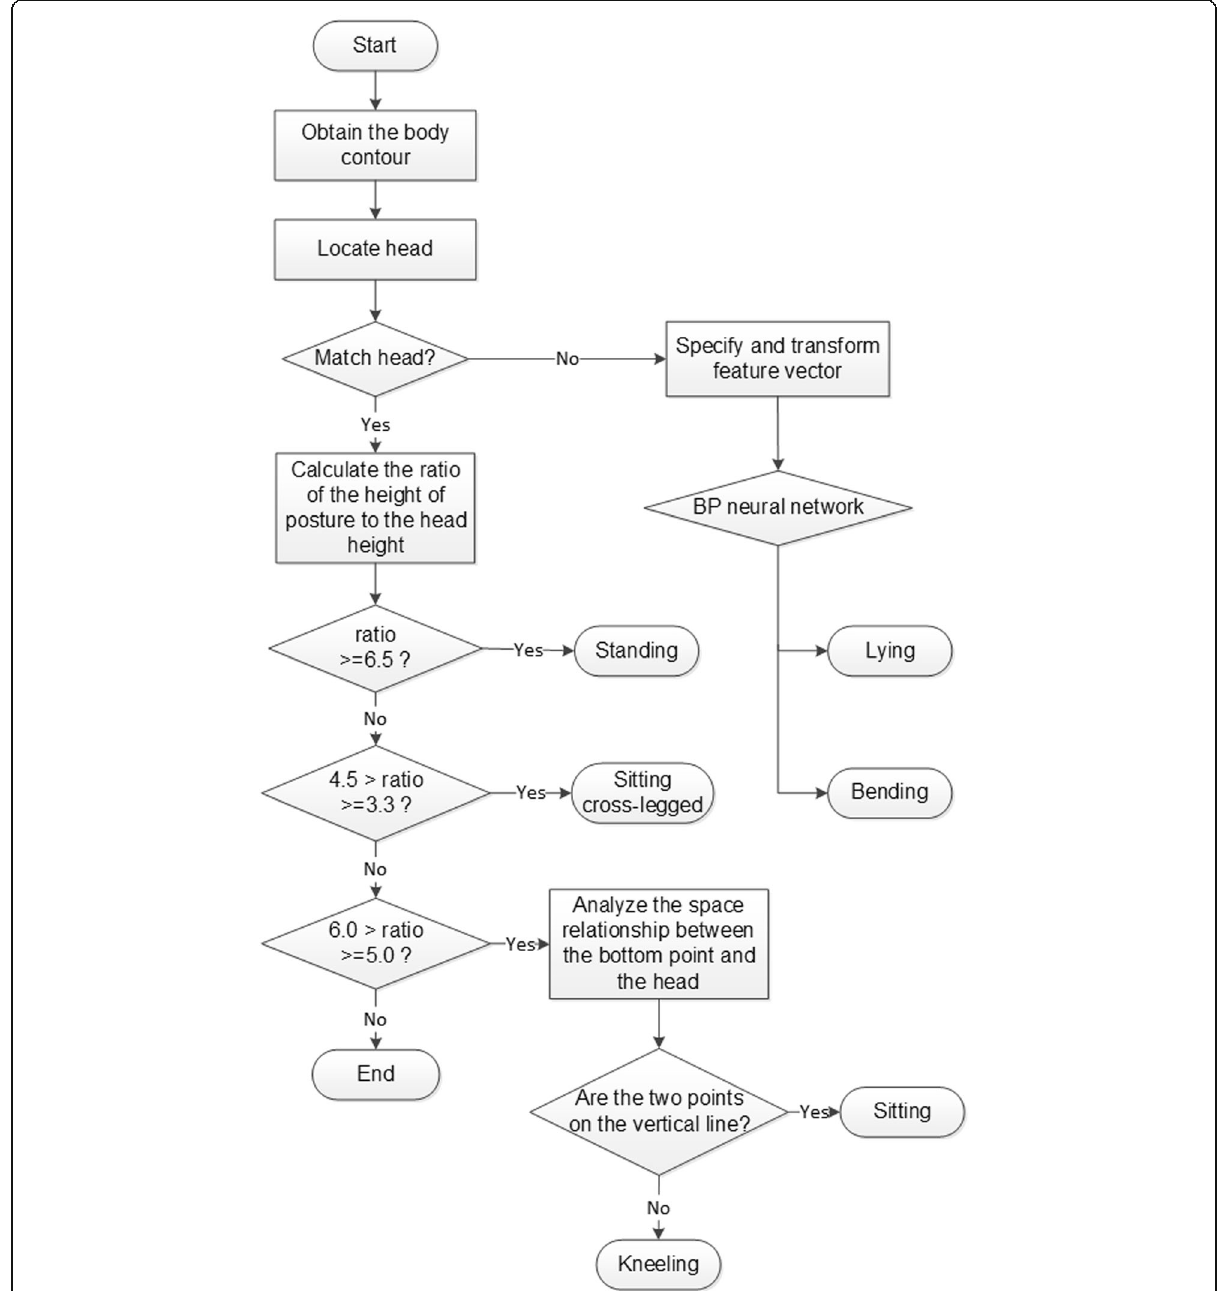
Fig. 2 General flow chart of our hybrid